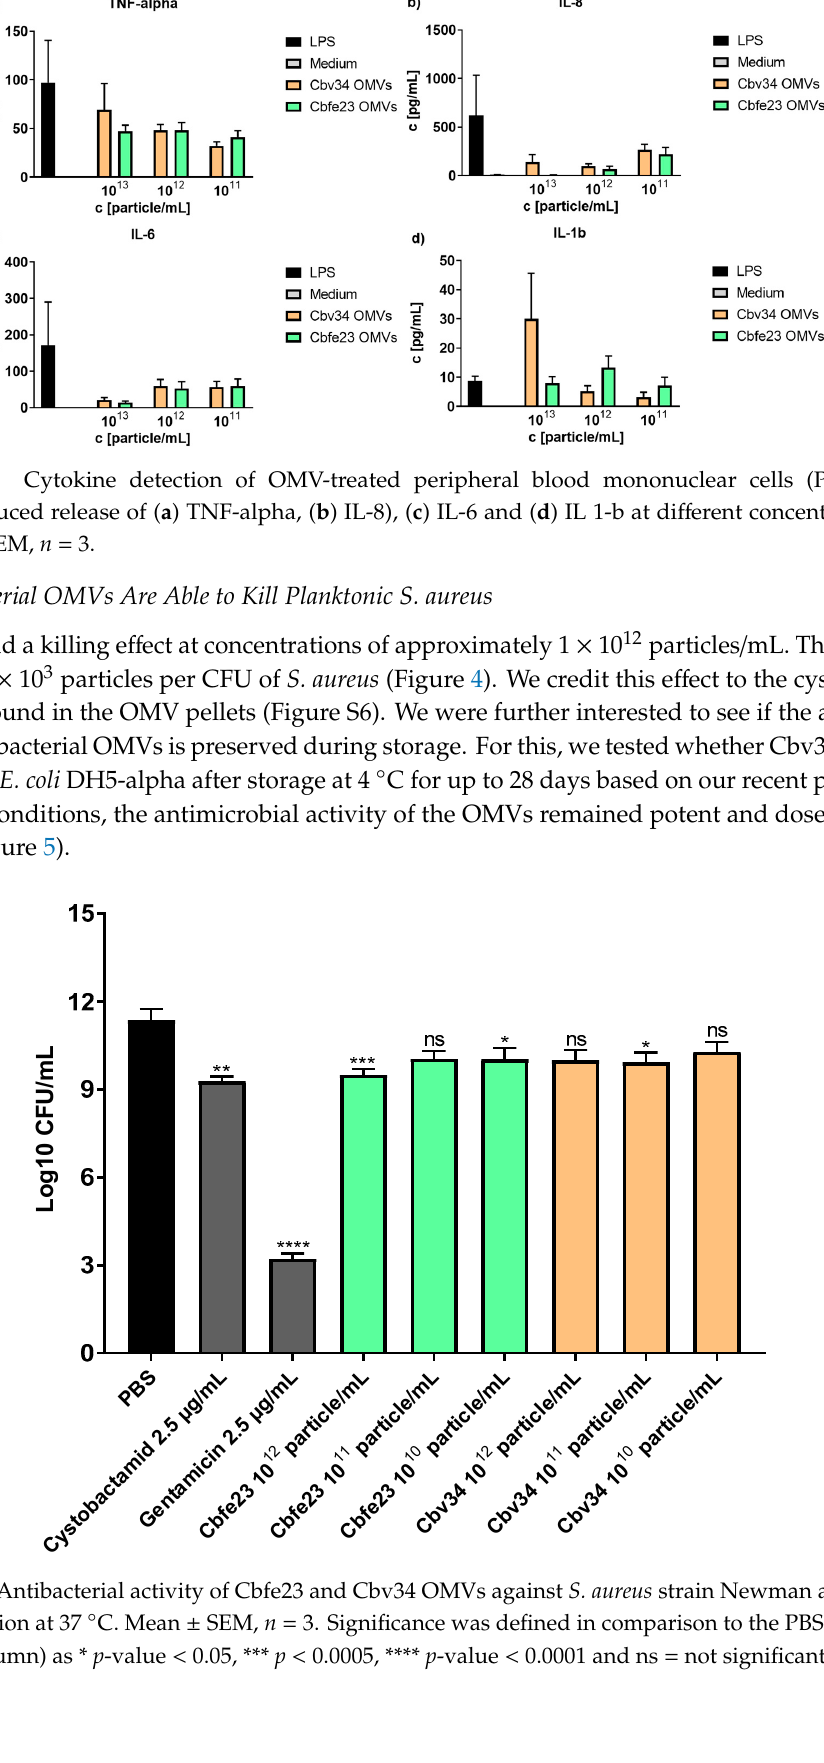
Figure 5. Antibacterial activity of Cbv34 OMVs against E. coli DH5-alpha right after isolation (fresh), and upon storage at 4 °C for 7, 14, 21 and 28 days. The treatment was done for 18 h at 37 °C. Mean ± SEM, n = 3. 3.5. OMVs Are Taken Up by Mammalian Cells The interaction with and uptake of the OMVs in A549 epithelial cells and RAW 264.7 immune cells were assessed by flow cytometry (Figures 6 and 7) and CLSM (Figure 8). In comparison to liposomes prepared from bacterial phospholipids, we observed a significantly slower uptake of OMVs in A549 cells at 4 and 24 h of incubation (Figure 6a,d). The MFI of the liposomes was significantly higher when compared to the OMVs at the 4 h time point with A549 cells (Figure 6b). The MFI difference remained high between Cbv34 OMVs and liposomes at 24 h, but it was not significant when Cbfe23 OMVs and liposomes were compared (Figure 6e). As for the uptake into RAW 264.7 cells, Cbfe23 OMVs and bacterial liposomes did not show any significant difference in